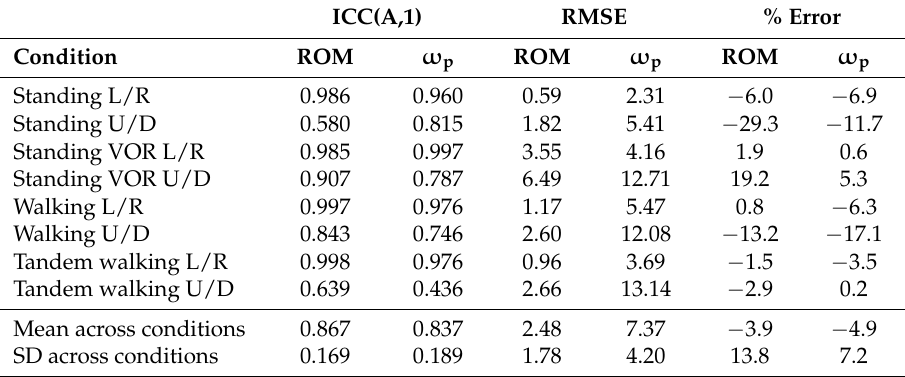
Table 4. Validity results comparing IMU to motion capture for trunk ROM and peak rotational